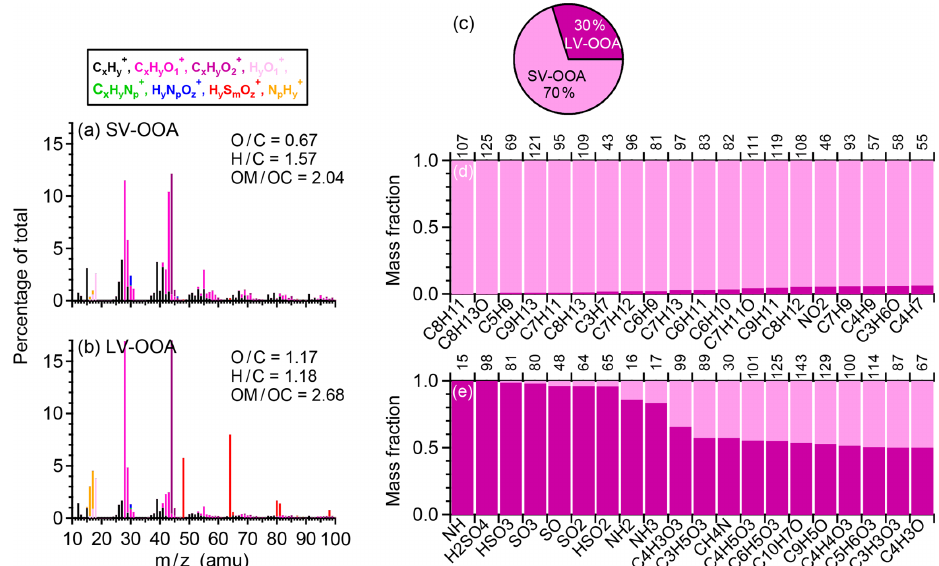
Figure 3. High-resolution mass spectra of (a) SV-OOA and (b) LV-OOA colored by eight ion families. The elemental ratios of OA determined using the IA method are shown in the legends. (c) Average OA composition. (d–e) The distribution of signals between SV-OOA and LV-OOA for 20 most abundant ions in SV-OOA (d) and LV-OOA (e) . The nominal masses of the ions are shown on the top axes of (d) and (e)